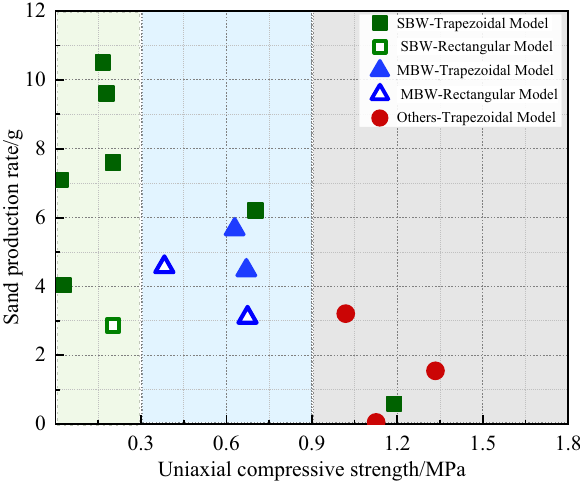
Fig. 7 Diagram of overall experimental results. Additional notes: As the UCS increased, other less wormhole-like sanding patterns appeared, which have been tentatively named “others,” but they were not many and not the main point of this paper. The authors have counted them for the sake of rigor, which may become the priorities of future